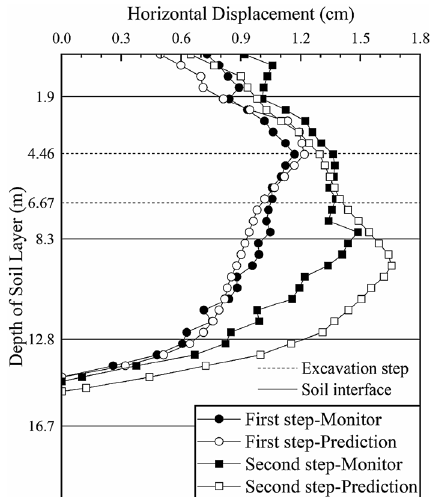
Figure 10. Deep horizontal displacement of section 2 before the inversion.